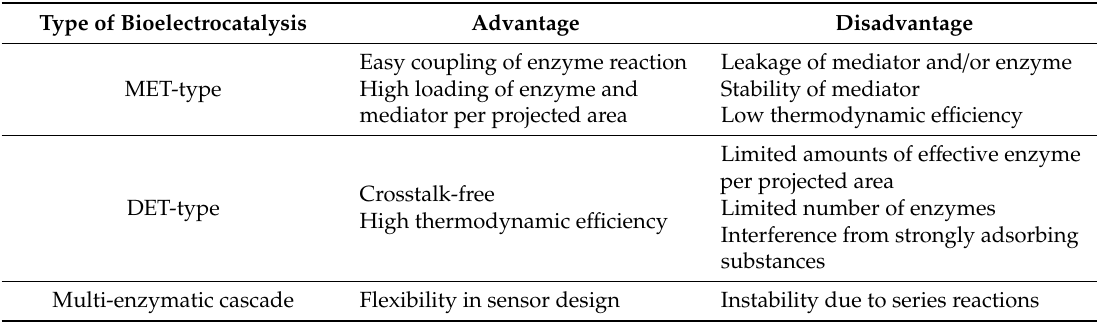
Table 2. Advantages and disadvantages of the bioelectrocatalytic systems for biosensing. Type of